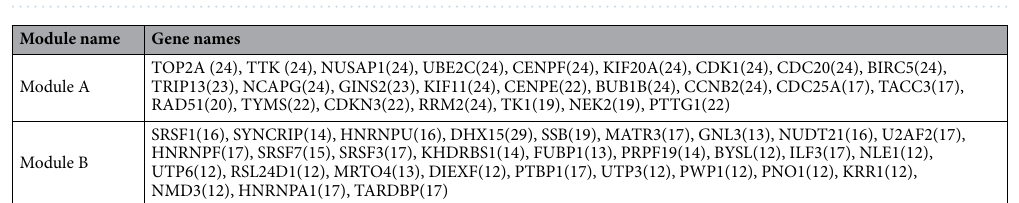
Figure 2. Gene co-expression network for the primary genes (disconnected genes were removed from the network). The size of the nodes indicates its degree. There are 391 nodes and 1273 edges in this network. DHX15 is the highest degree node in this network.